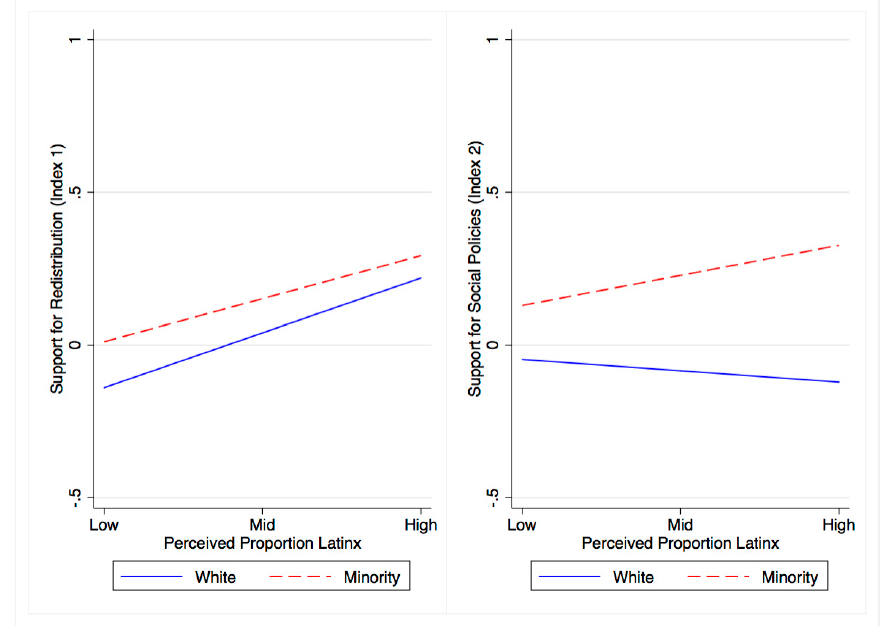
Figure 8. Bivariate fitted linear regression lines of support for redistribution and social policies indices (standardized) and perceived neighborhood proportion of Latinxs by respondent race.